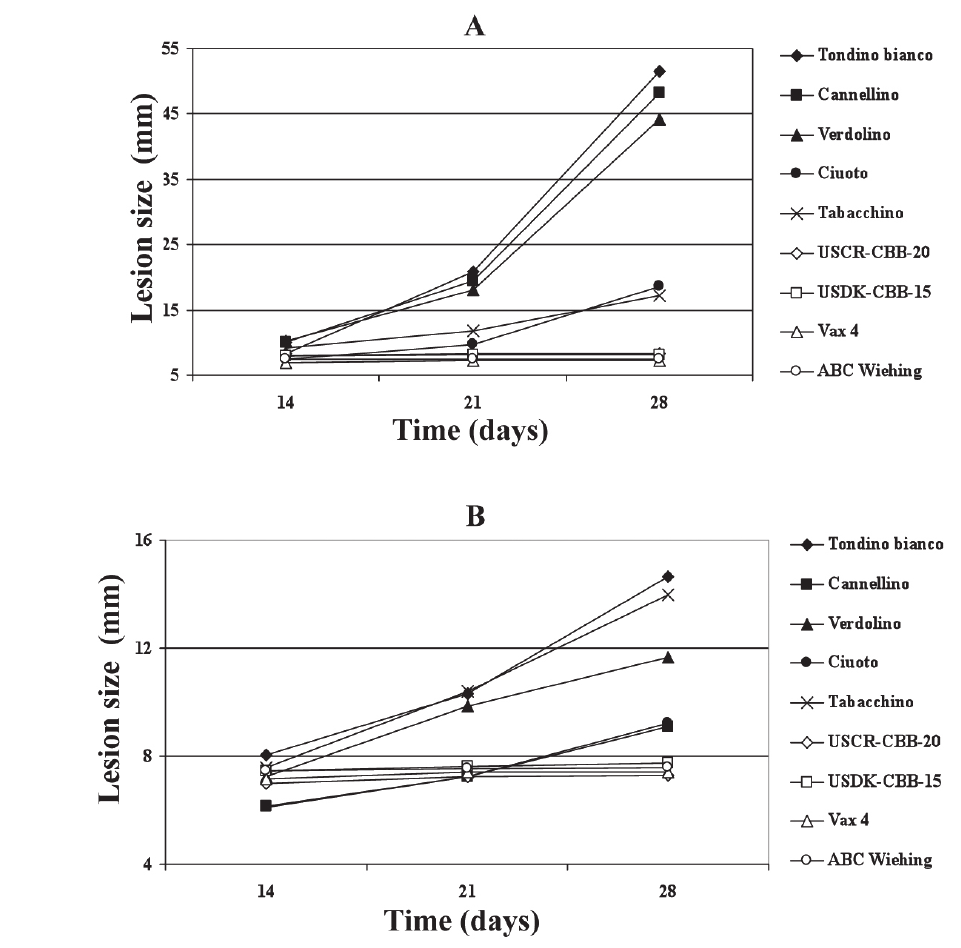
Figure 2. Response given by the traditional bean cultivars of the Fagioli di Sarconi and by CBB resistant breeding- lines to artificial inoculation with strain USB749 of Xanthomonas axonopodis pv. phaseoli var. fuscans (A) and strain USB771 (B) of X. a. pv. phaseoli